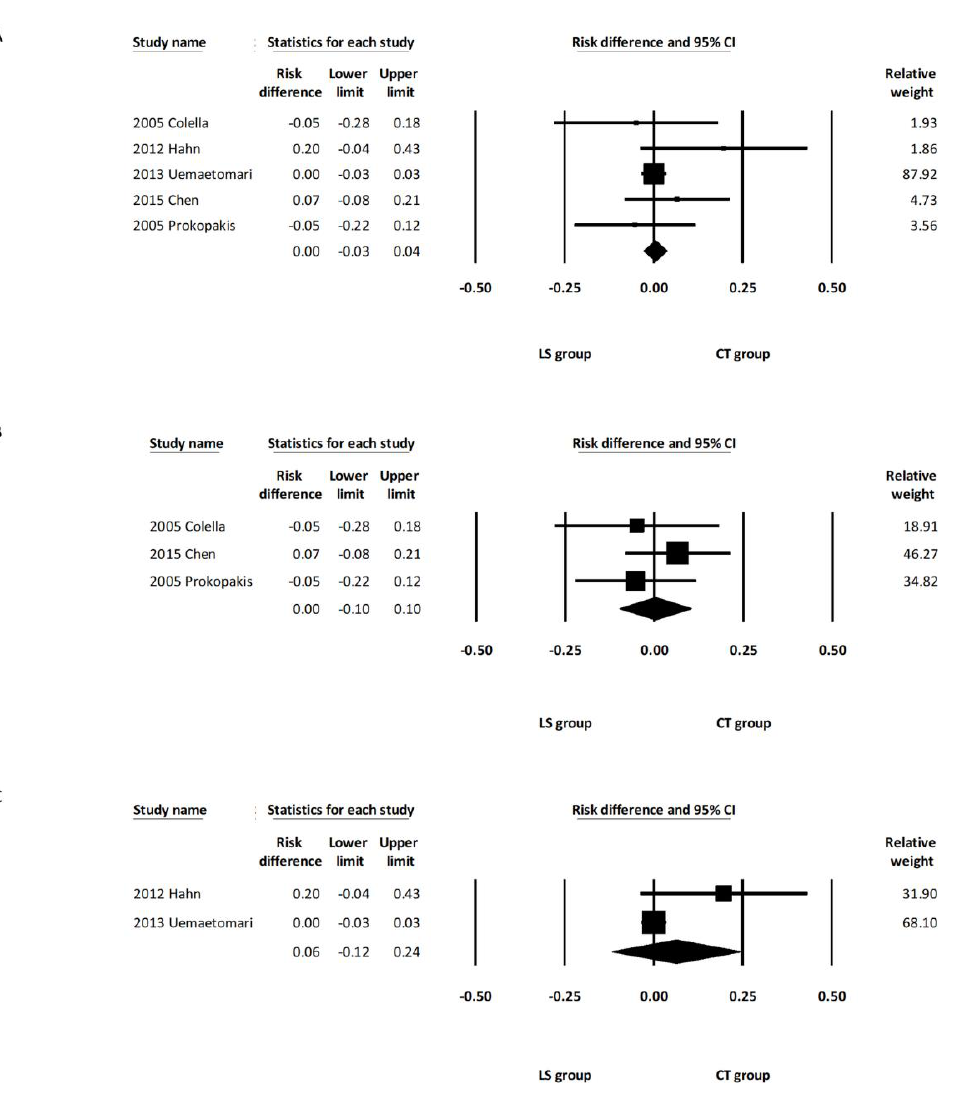
Figure 4. Forest plot of the incidence of temporary facial palsy after parotidectomy. ( A ) Overall study group. ( B ) Studies including only the LSP device. ( C ) Studies including only the LSJ de- vice. LS, LigaSure; LSP, LigaSure Precise; LSJ, LigaSure Small Jaw; CT, conventional technique; CI confidence